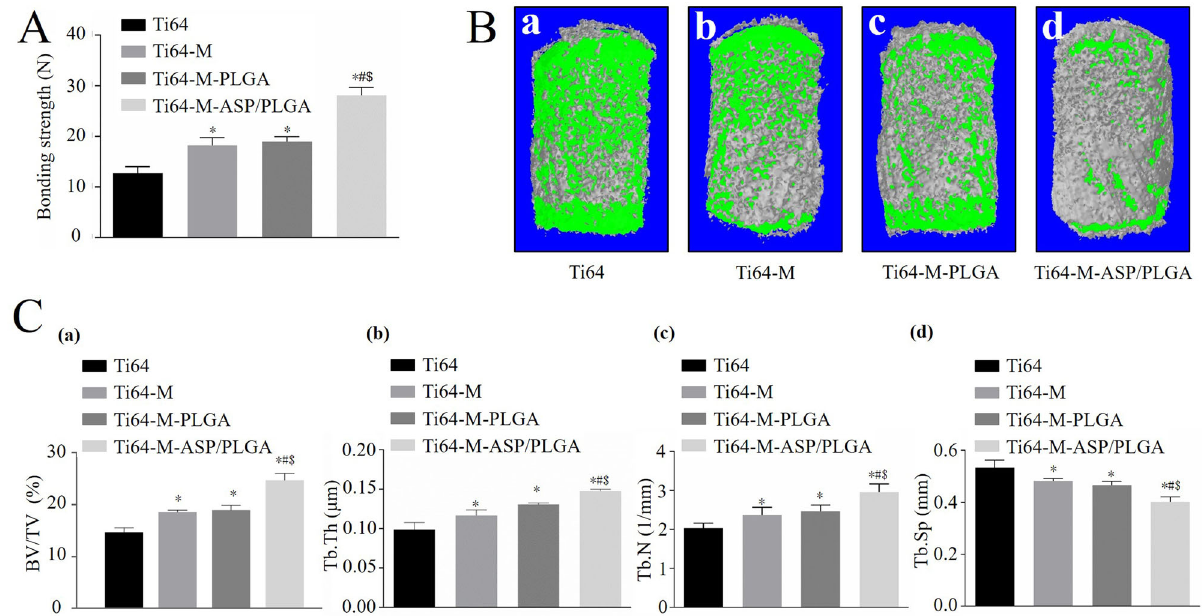
Fig. 7 In vivo effects of implants with various surfaces in experimental rat model. After 4 weeks of implantation, biomechanical push out test ( A ), micro-CT 3D reconstruction ( B ) and quantitative analysis of BV/